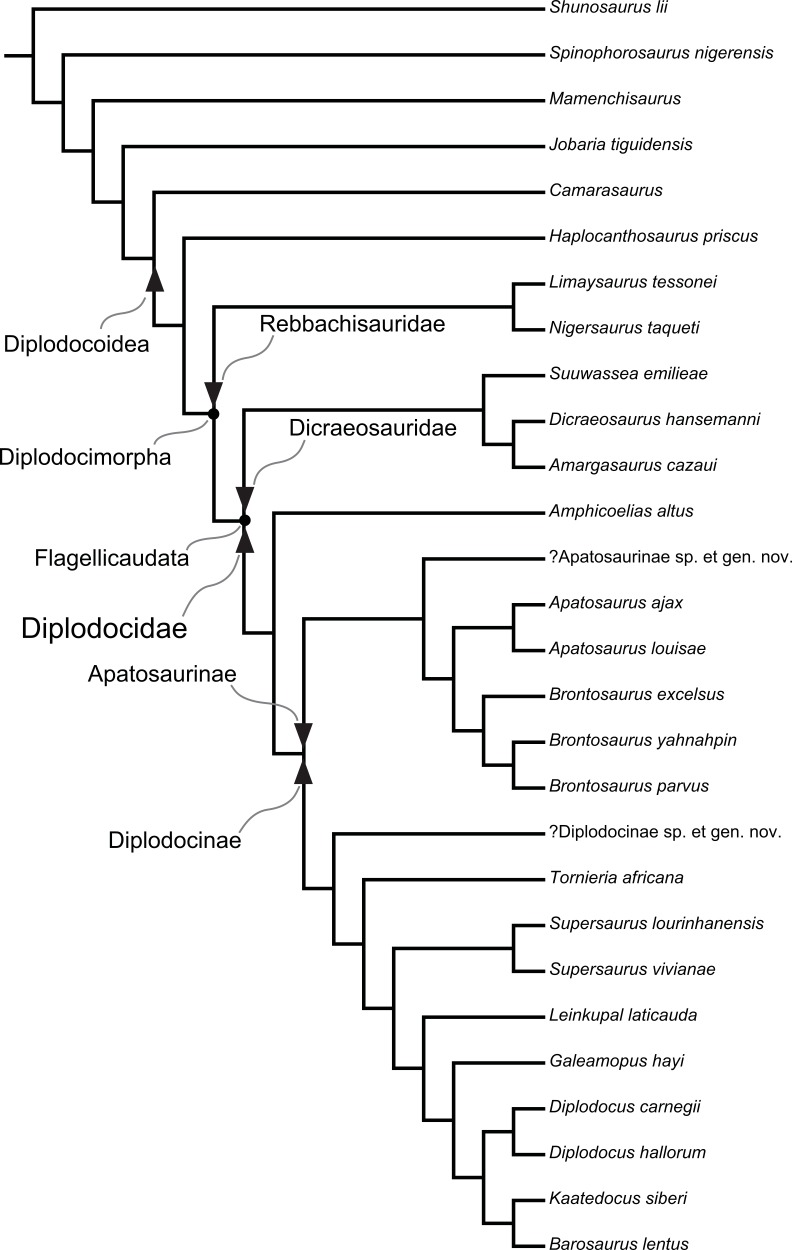
Speciel-level cladogram of Diplodocidae.Combined cladogram of diplodocid species-level intrarelationships, summarizing the results of the present thesis. Stem-based higher-level taxa are marked by an arrowhead, node-based taxa by a dot.